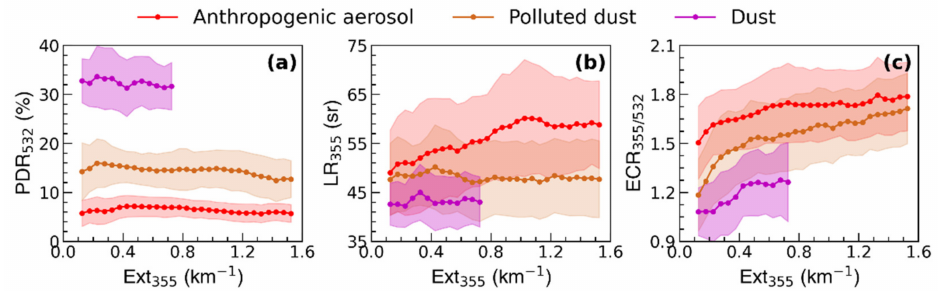
Figure 10. The trend of average aerosol optical parameters of key aerosol types with the aggravation of air pollution. Solid lines show the ( a ) PDR 532 , ( b ) LR 355 , and ( c ) ECR 355/532 variation along with the increasement in EXT 355 . The step of EXT 355 is 0.05 km − 1 . The envelope over the vertical bars represent one standard deviation at each EXT 355 .